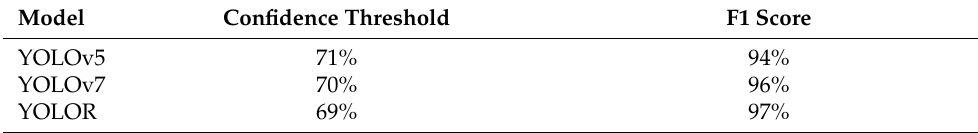
Table 9. Confidence threshold values that optimised the F1 score for each YOLO. Model